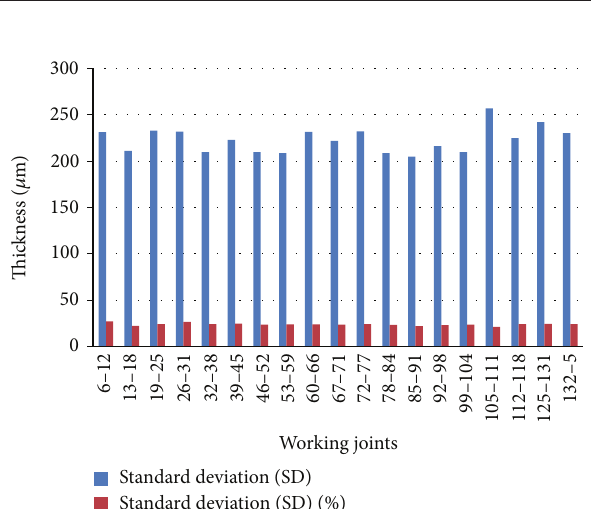
Figure 9: Standard deviation of the total thickness coatings to concrete surface of the internal shell.